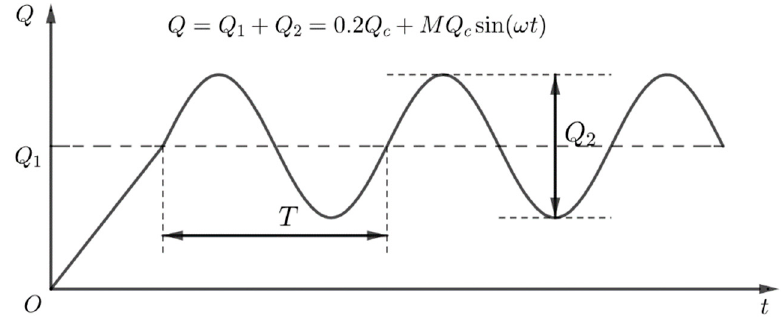
Figure 4. The waveform of the cyclic load test.